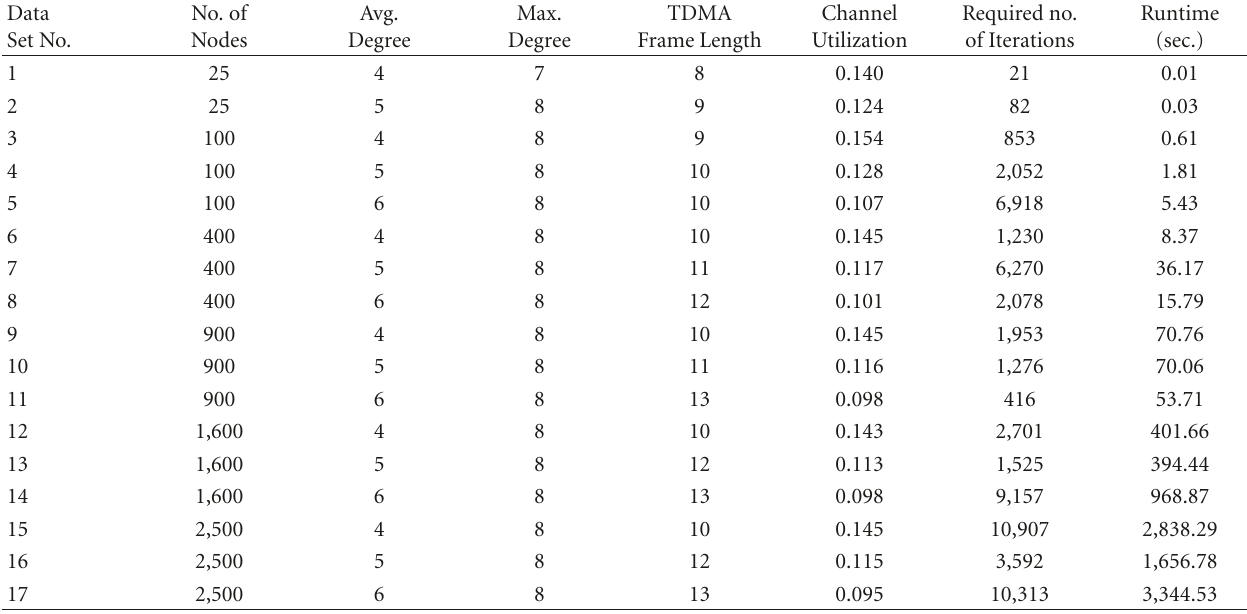
Table 3: Simulation Results with Randomly Generated Problem